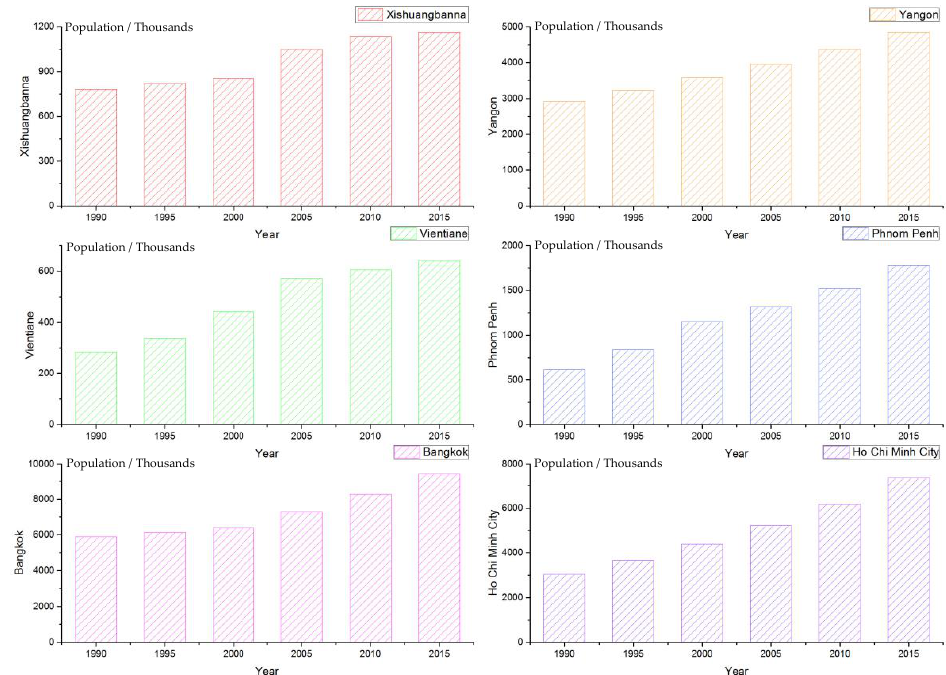
Figure 2. Population growth of the typical cities from 1990 to 2015.